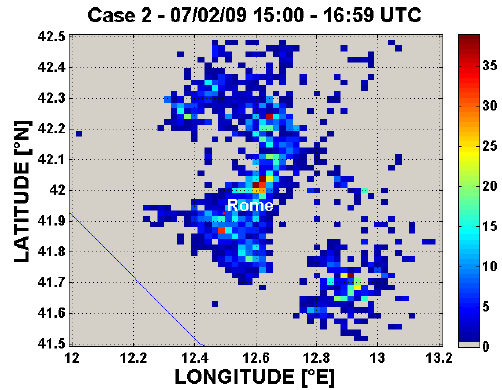
Fig. 8. Same as Fig. 7, but for the Rome area (Case 2) between 15:00 and 16:59UTC, 2 July 2009.